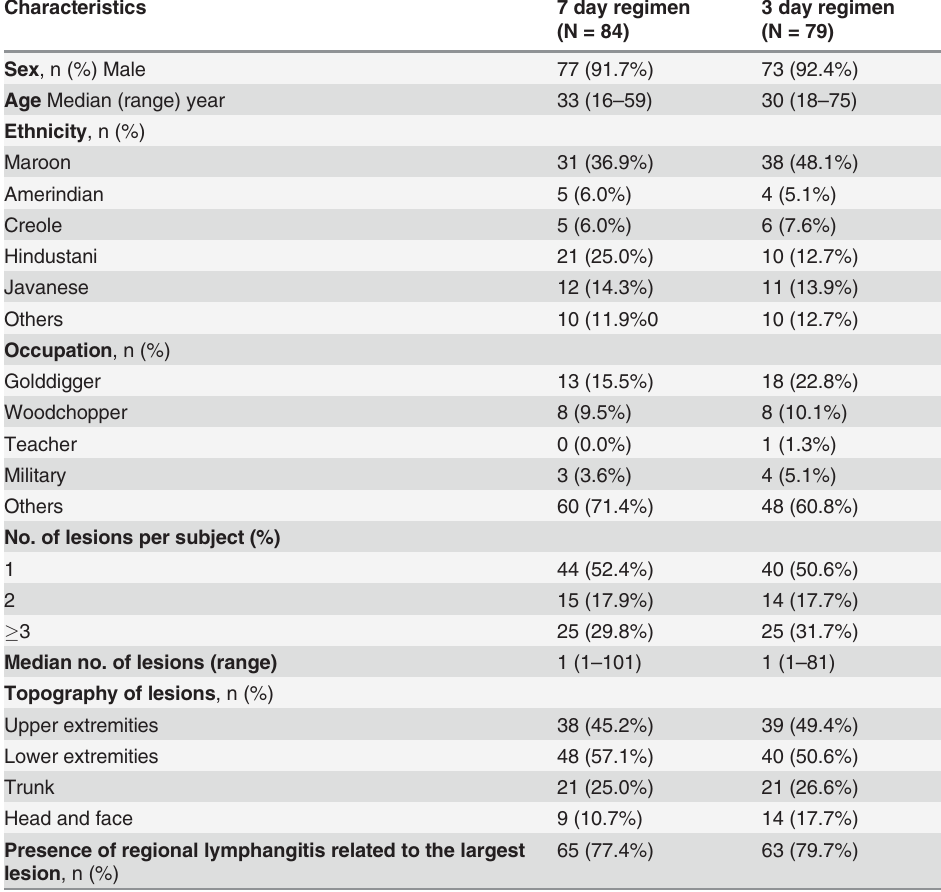
Table 1. Baseline characteristics of included patients with cutaneous leishmaniasis in Suriname from 2010 – 2013 according to treatment group.